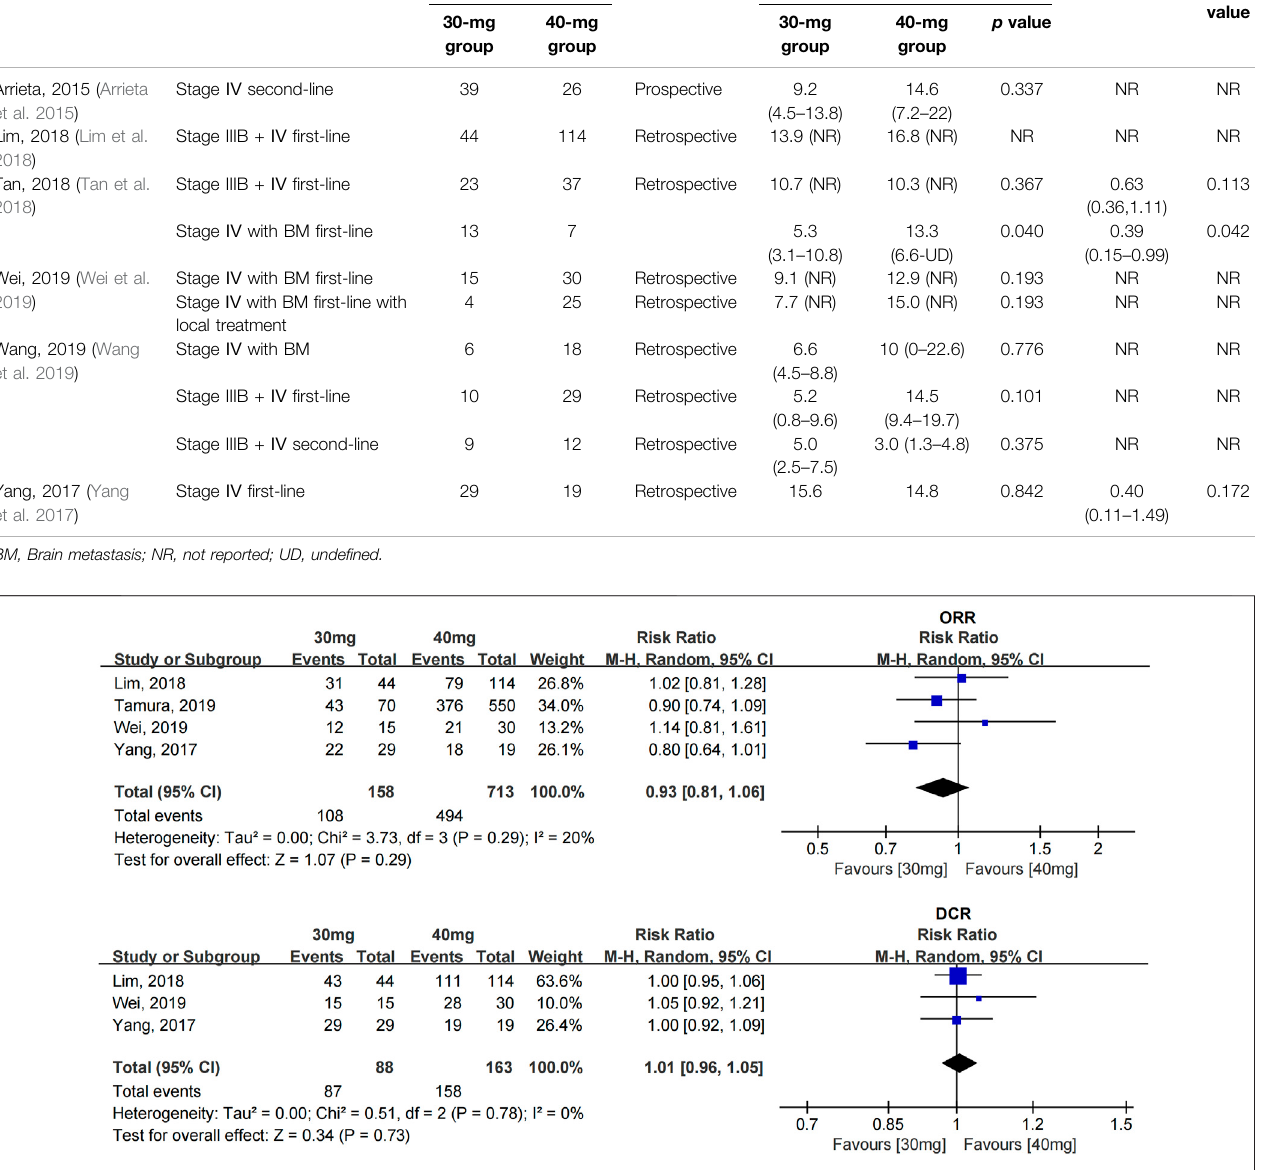
Frontiers in Pharmacology |